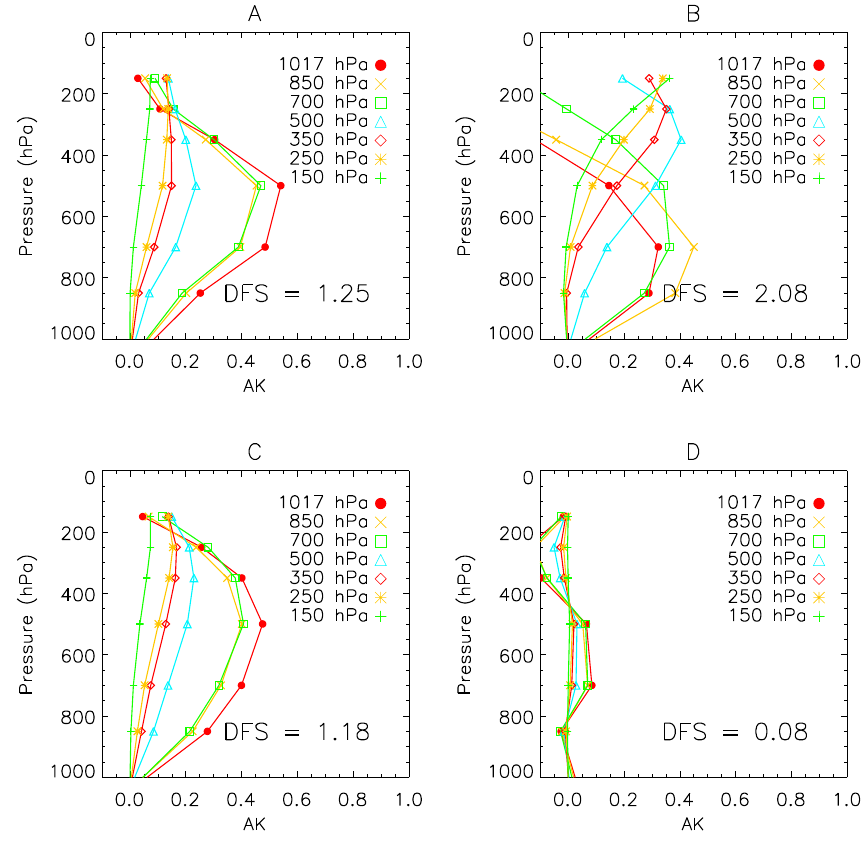
Fig. 10. Daytime and ocean averaging kernels over the Southern Africa region for 1 September 2007, for: (A) Adjusted MOPITT V3 averaging kernels converted onto the IASI pressure grid A MOP3” ; (B) IASI averaging kernels at pressure levels closest to the MOPITT V3 pressure levels A IASI ; (C) A MOP3” A IASI ; and (D) A MOP3” − A MOP3” A IASI